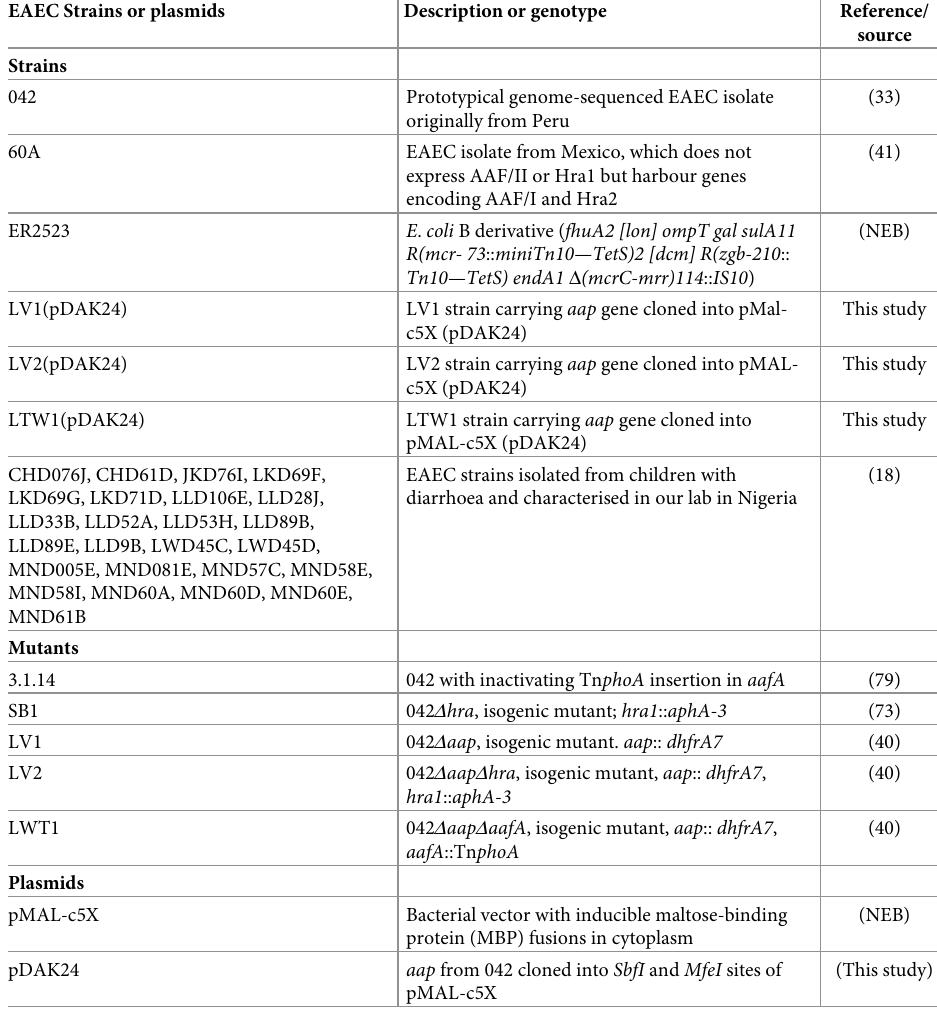
Table 1. Reference strains and EAEC strains used in this